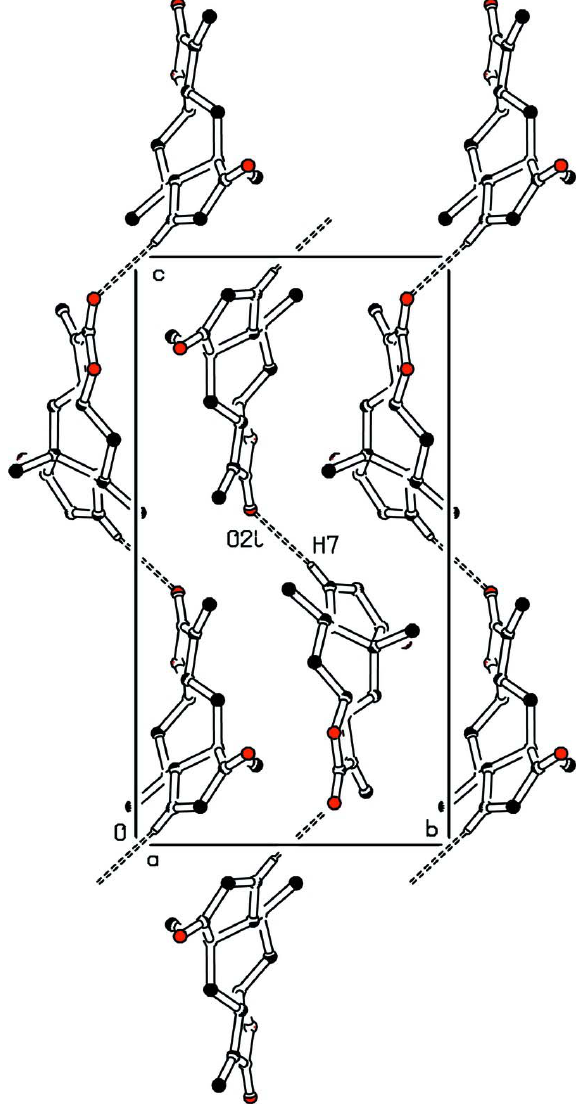
Part of the crystal structure showing the formation of C(9) along [001]. For the sake of clarity, H atoms not involved in hydrogen bonding have been omitted. [Symmetry code: (i) 1/2 - x , 1 - y , 1/2 + z